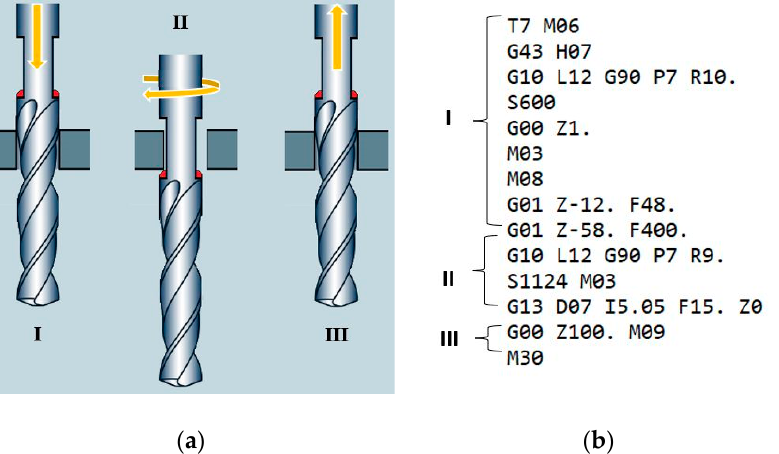
Figure 2. Integration of drill and deburring insert: three stages of the proposed process ( a ), machine code for drilling and deburring ( b ).